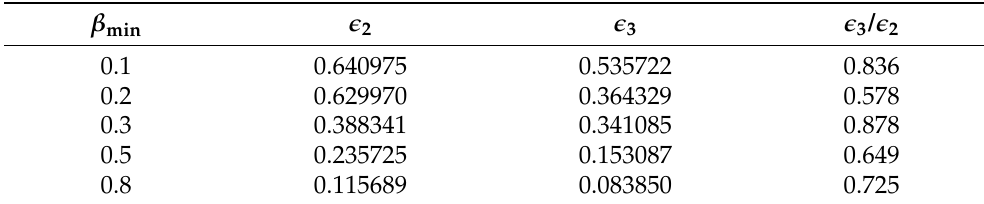
Table 2. Effect on the largest non-trivial diffusion operator eigenvalues of increasing β min , the density threshold coefficient. (cid:101) 2 is the largest non-trivial eigenvalue and (cid:101) 3 is the second largest. The kernel distance scaling parameter was D = 2 in all cases and the number of required gridpoint samples at each timestep was